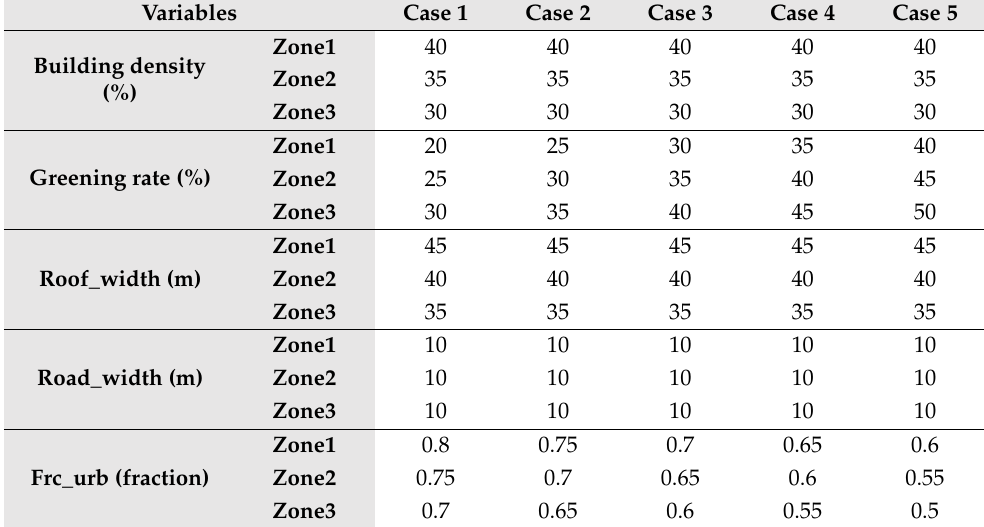
Table 3. Parameters of case